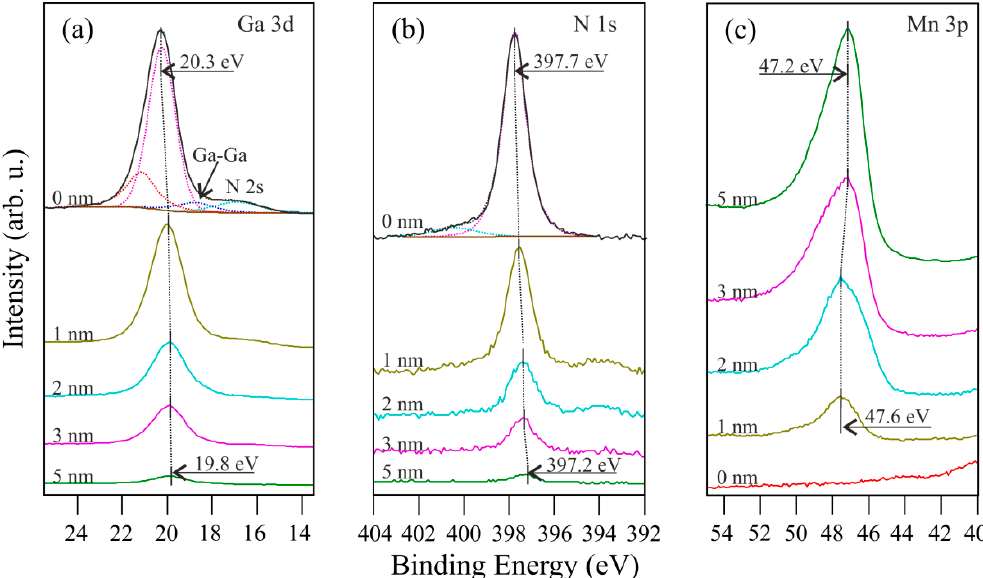
Figure 12. Evolution of spectra for ( a ) Ga ‐ 3d, ( b ) N ‐ 1s, and ( c ) Mn ‐ 3p with the thickness of deposited Mn film. XPS measurements were performed with nonmonochromatic 1253.6 eV photons. Data previously published in [22].